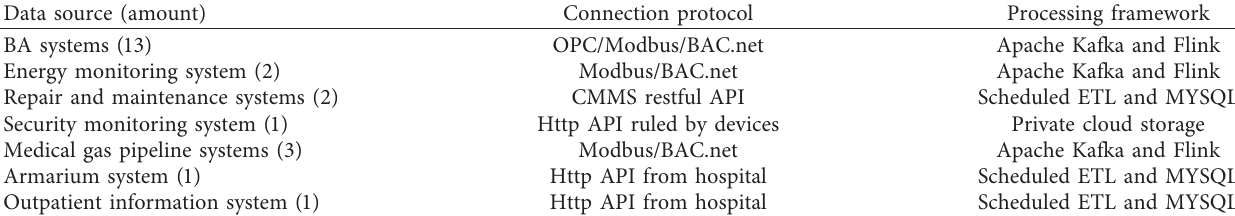
Table 2: Dynamic data connection and processing method.